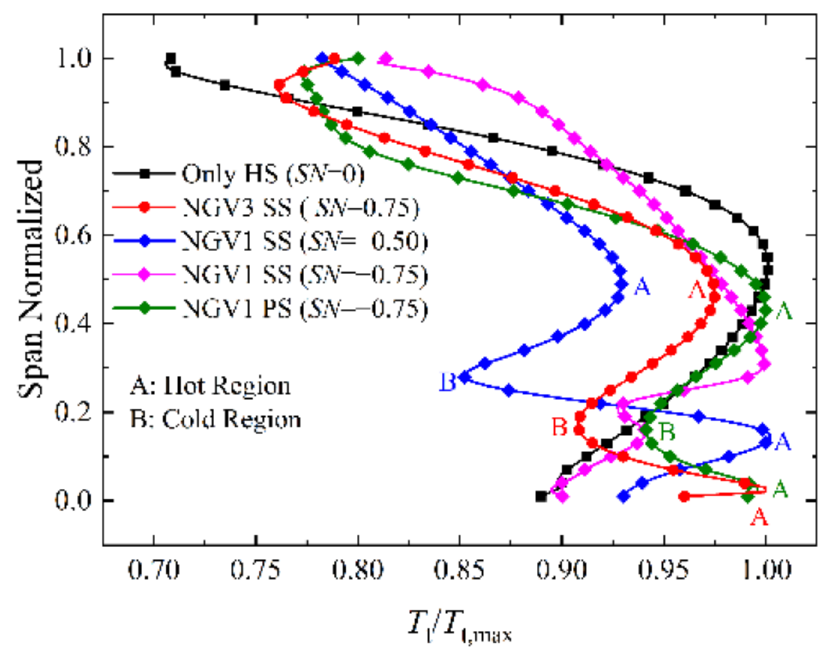
Figure 21. Total temperature (normalized by the local maximum value) distributions along line of Z / Bx =